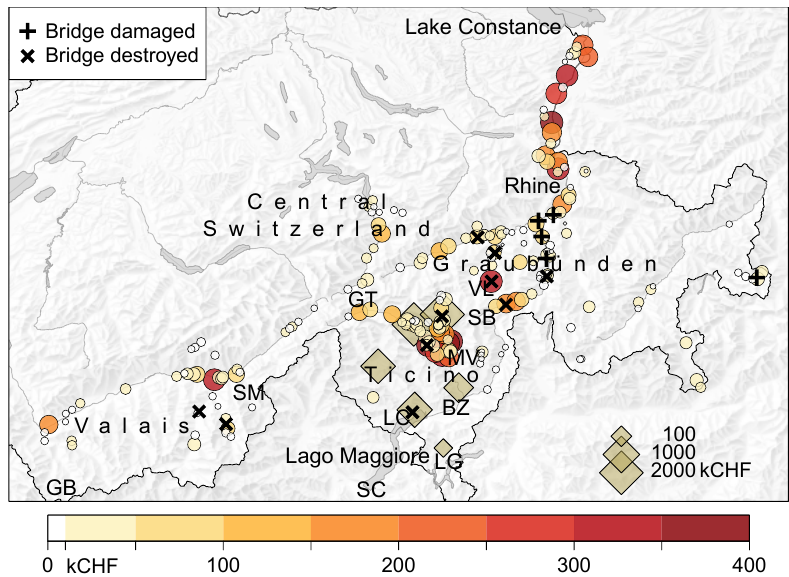
Figure 2. Amounts of damage (in thousands of Swiss Francs, kCHF) as collected from contemporary surveys in five Cantons in southeastern Switzerland. Filled circles and diamonds refer to amounts of damage per municipality and administrative region, respectively, where avail- able. Note that both regional and municipality-level values are plotted where possible. Crosses indicate reported damage to bridges. Labels refer to locations mentioned in the text: BZ Bellinzona, GB Grand St. Bernard, GT Gotthard, LC Locarno, LG Lugano, MV Malvaglia, SB San Bernardino, SM Simplon, VL